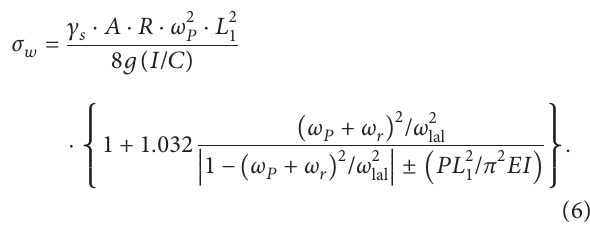
� drillstring radius, ω o